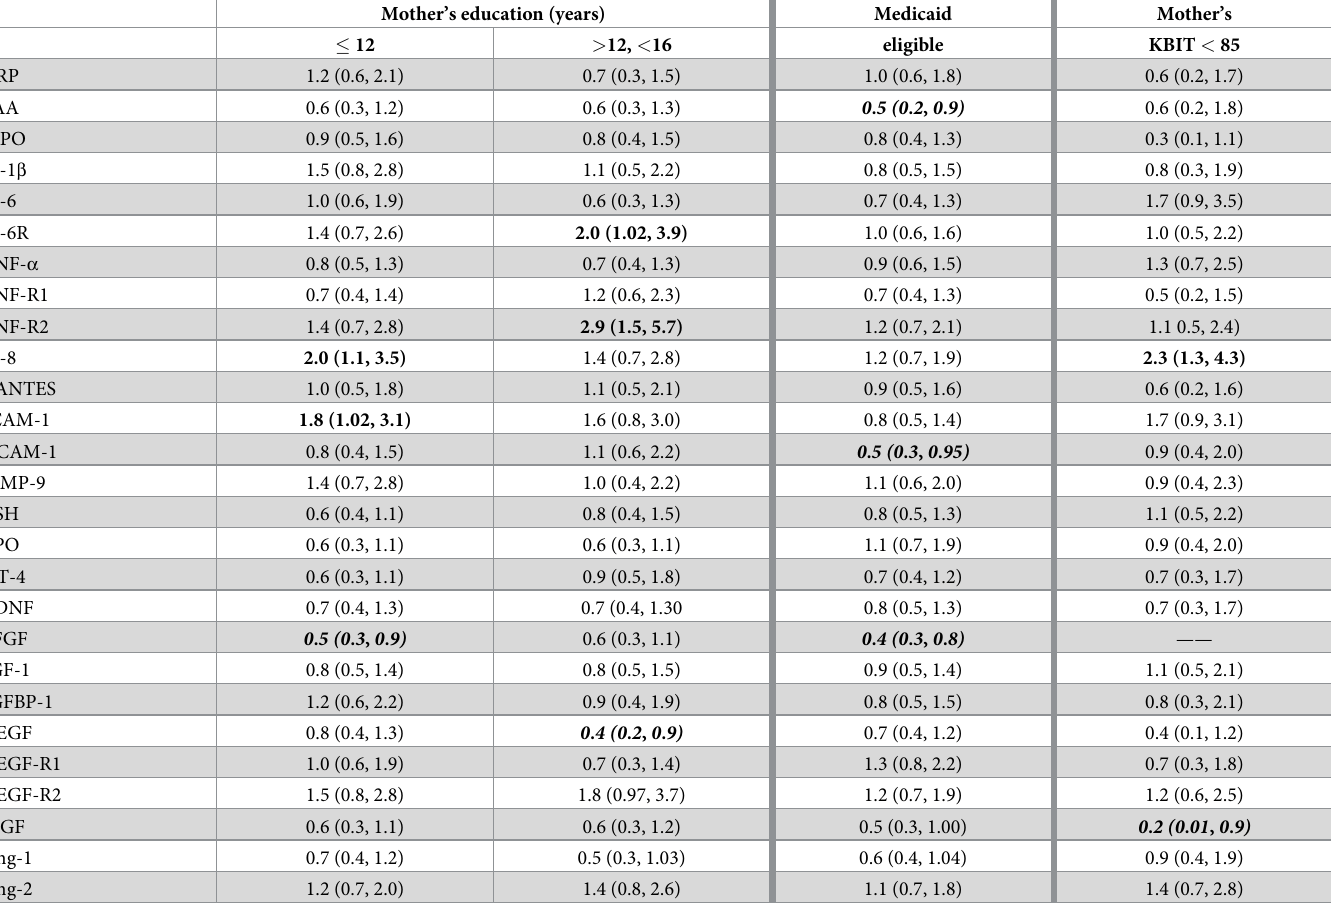
Table 3. Odds ratios (95% confidence intervals) for a top-quartile concentration of the protein listed on the left on 2 days during the late epoch among children whose mother had the characteristic listed at the top of the column relative to the risk among children who did not have that characteristic. The referent group for the 2 maternal education characteristics is comprised of children whose mother had the equivalent of a college education. Bold indicates odds ratios significantly > 1 (p < 0.05) and bold italic indicates odds ratios significantly < 1 (p <